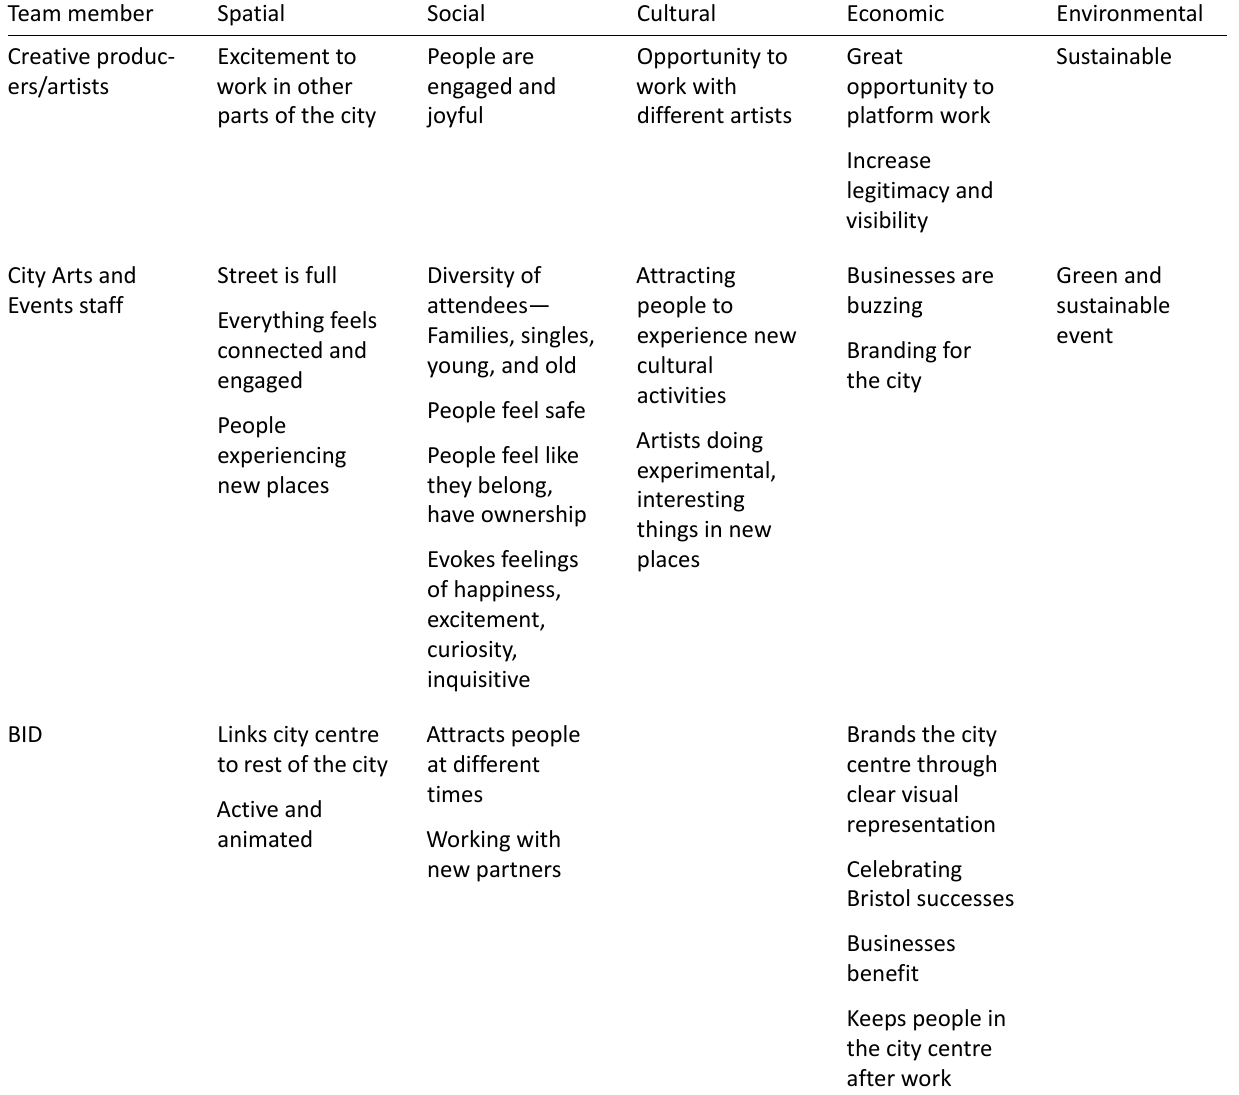
Table 2. Festival team visions and